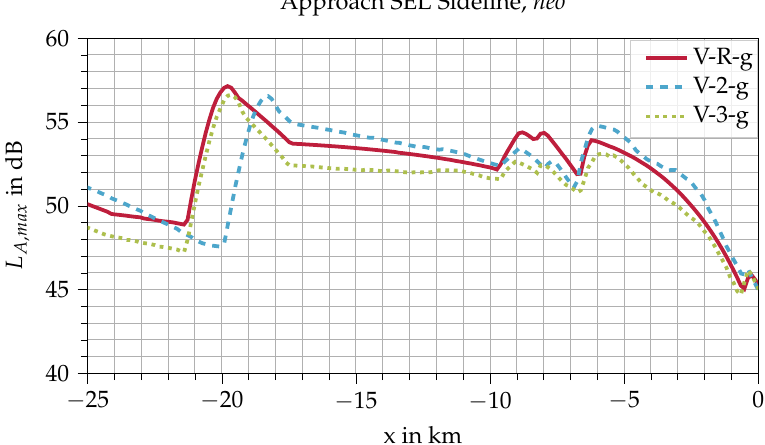
Figure 13. L A , max level 1000m sideline during approach ( neo ).